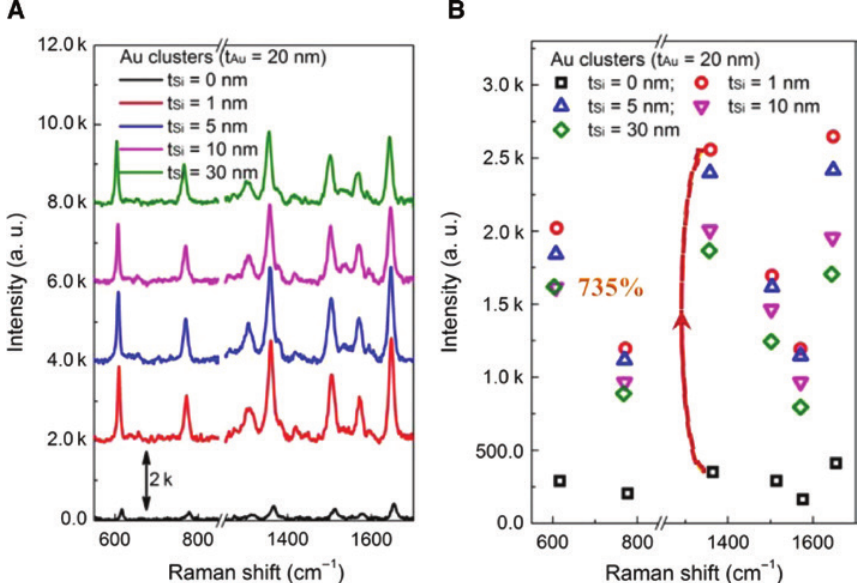
Figure 3: Surface-enhanced Raman scattering (SERS) performance for the Au clusters based substrate. (A) SERS spectral properties of the Au clusters under a tuning thickness of silicon buffer layers. (B) The plotted intensity spectrum of the Raman modes as a function of the silicon layer’s thickness. The dashed red arrow indicates a 735% enhancement factor for the 1-nm-thick silicon sandwiched Au clusters to that of the Au clusters structure without the silicon